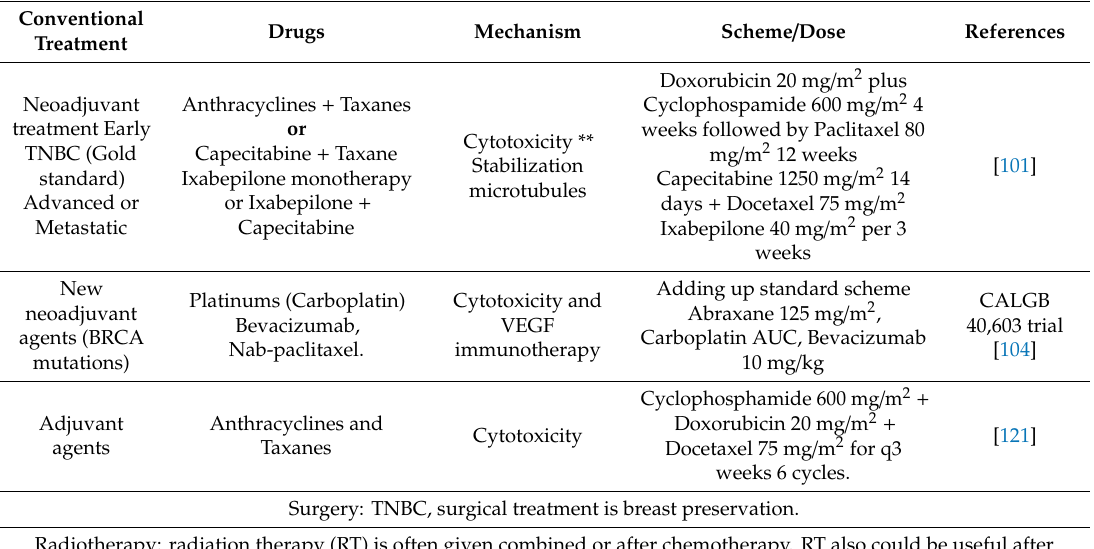
Table 1. Conventional treatment of triple negative breast cancer